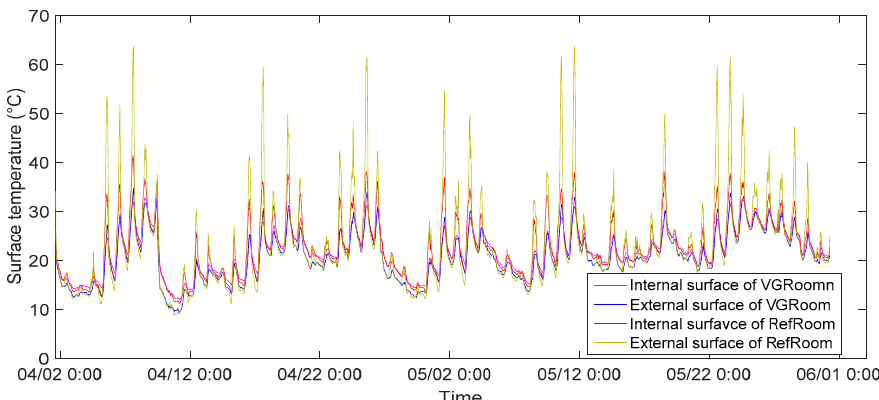
Figure 10. Internal and external surface temperatures of the west walls of the two experimental rooms.